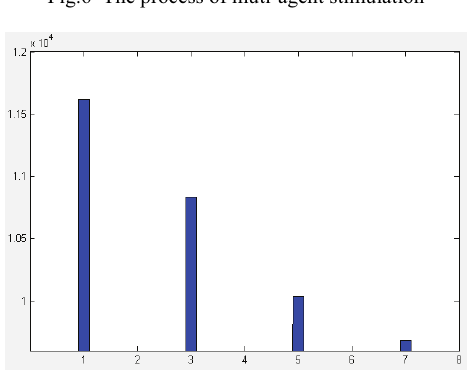
Fig.6 The process of muti-agent stimulation